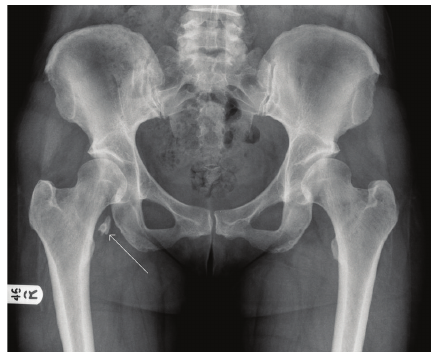
Figure 1: An anterior-posterior plain radiograph of the patient’s hips taken 3 months prior to the repeat left psoas release surgery. There are only mild dysplastic changes present in the left hip. There is significant ossification, demonstrated by the arrow, superior to the right lesser trochanter, which is likely secondary to the patient’s right psoas tenotomy undertaken 11 years ago.